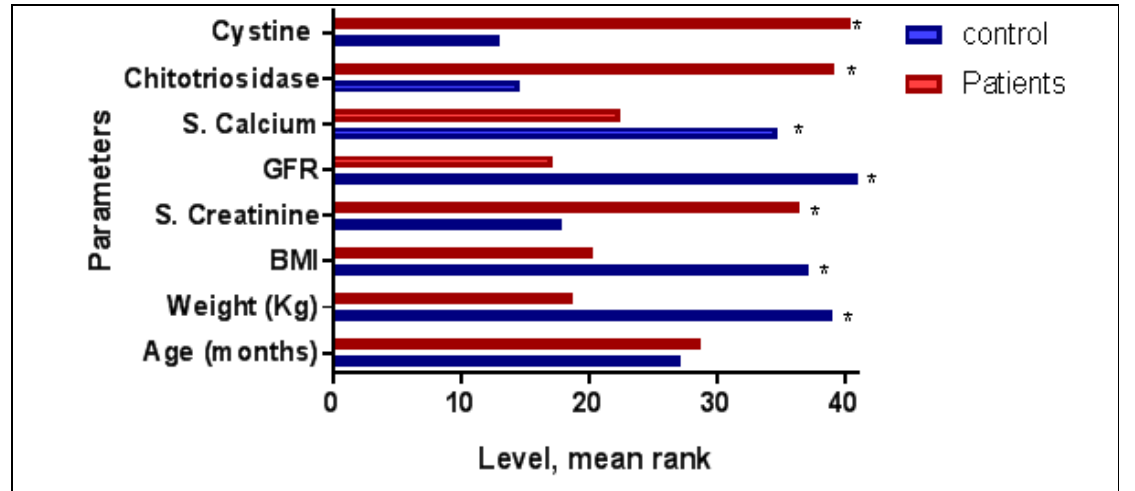
Figure 1.Comparison between different parameters of control and patients *Significant (P-value <0.05) difference between mean